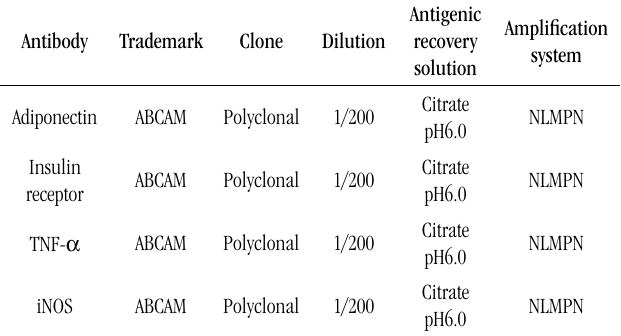
tABLE 1 – Used antibodies and reaction protocols Antibody